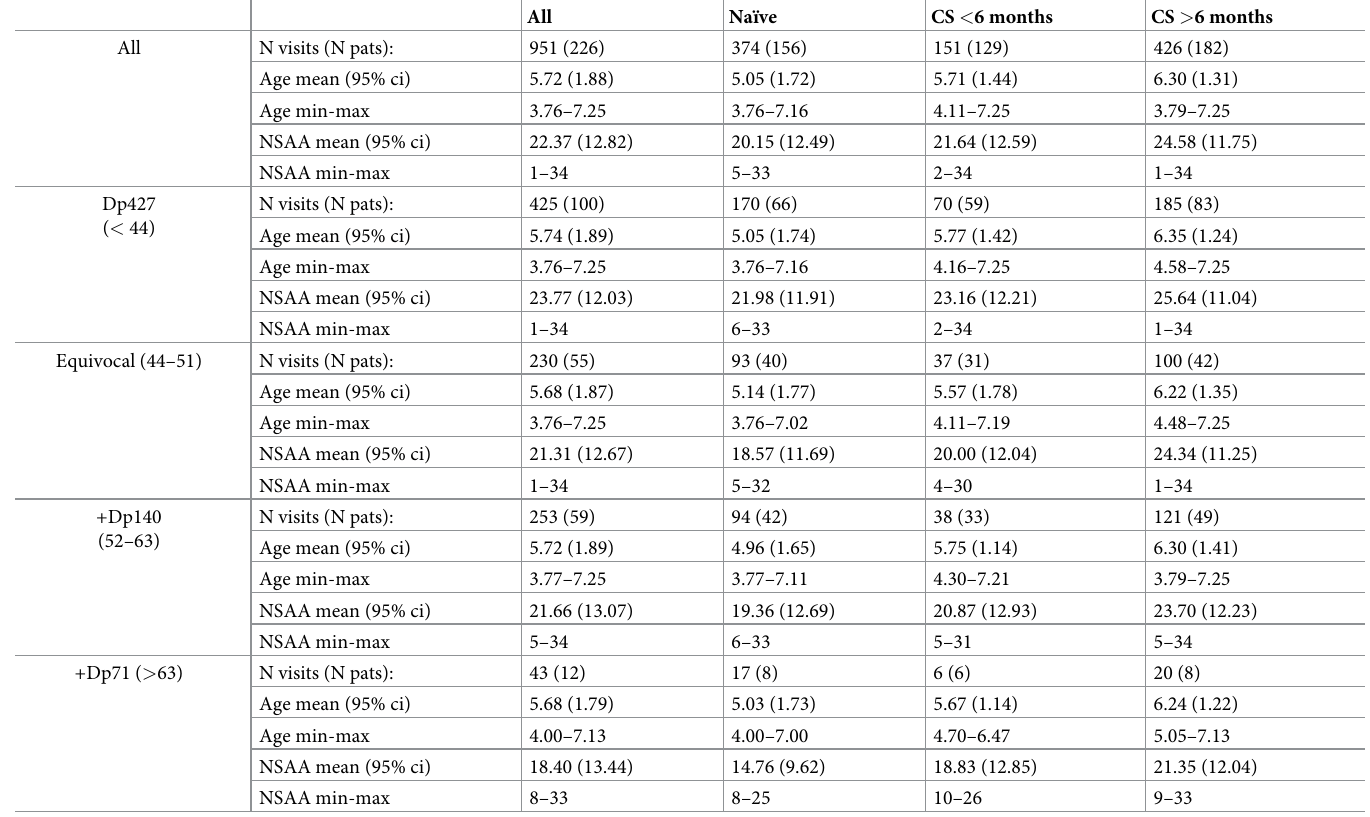
Table 1. Population characteristics subdivided by brain dystrophin involvement and corticosteroids. All Na ï ve CS < 6 months CS > 6